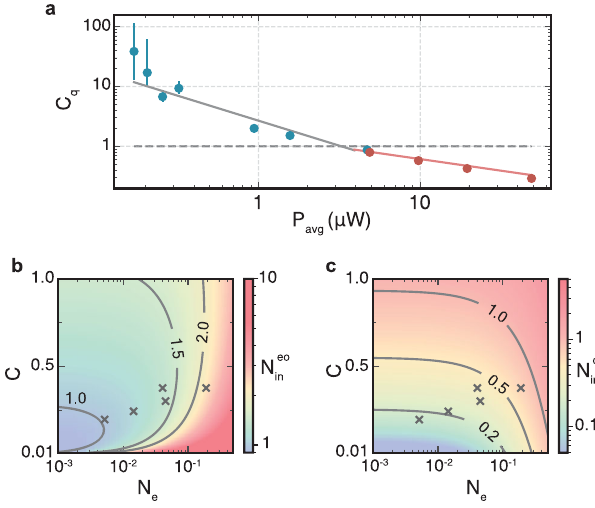
Fig. 4 Quantum cooperativity and equivalent input added noise. a Inferred quantum cooperativity C q = C / N e for the measured output noise values shown in Fig. 3c. b , c Inferred optics-to-microwave N eo to-optics N oe ) equivalent added input noise as a function of C and N e for in S ¼ 0 : 22. Crosses mark the lowest fi ve blue measurement points in Fig.